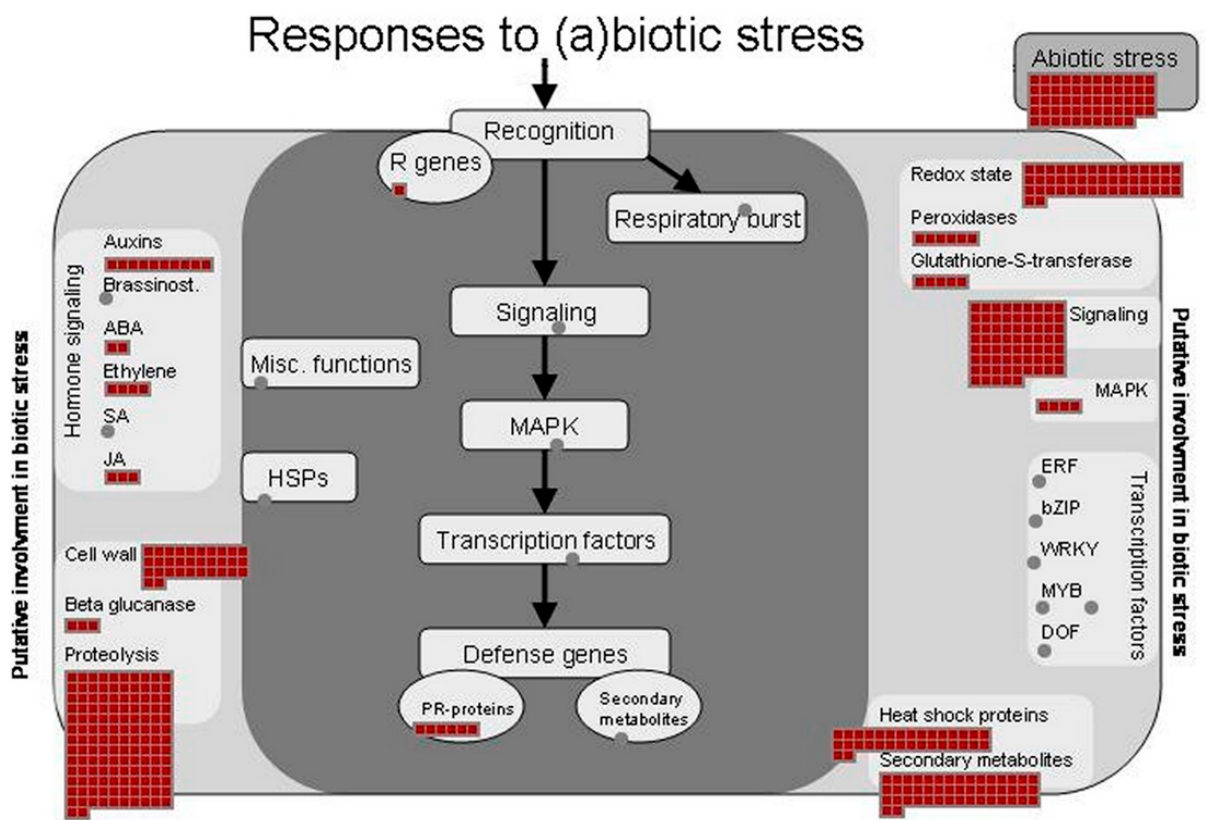
Figure 6. Proteins identified in ginseng involved in (a)biotic stress pathways. The identified proteins were classified into metabolic functional classes according to the BIN ontology. The schematic metabolic pathways were obtained by MapMan software.